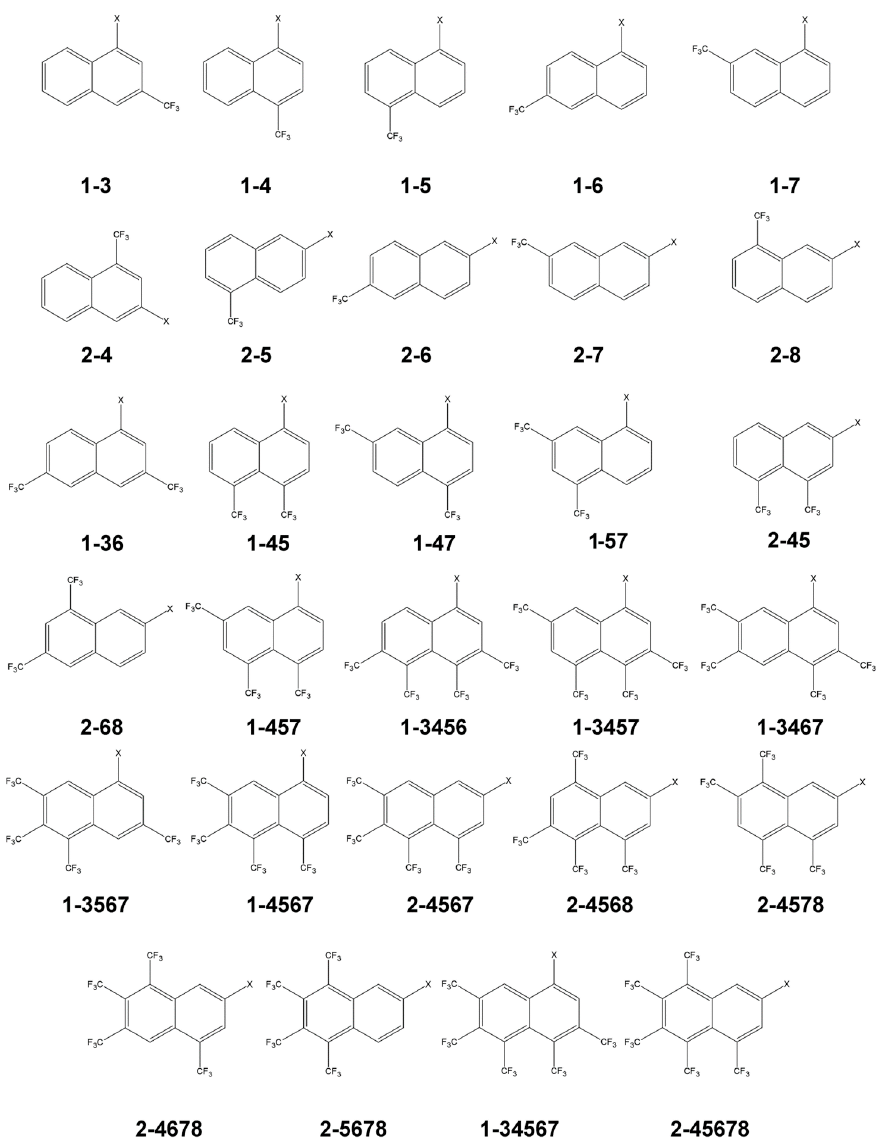
Figure 1. Types of naphthalene derivatives and their symbols (X—substituent; see Table 1).